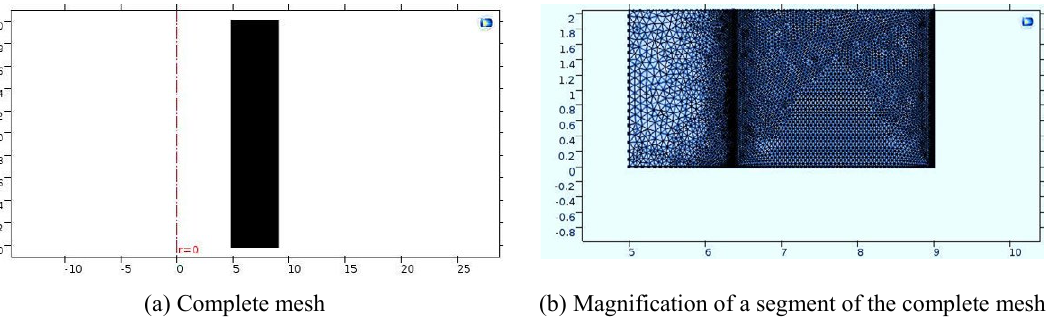
Fig. 4 Mesh used in the simulation; (a) Complete mesh and (b) Magnification of a segment of the complete mesh